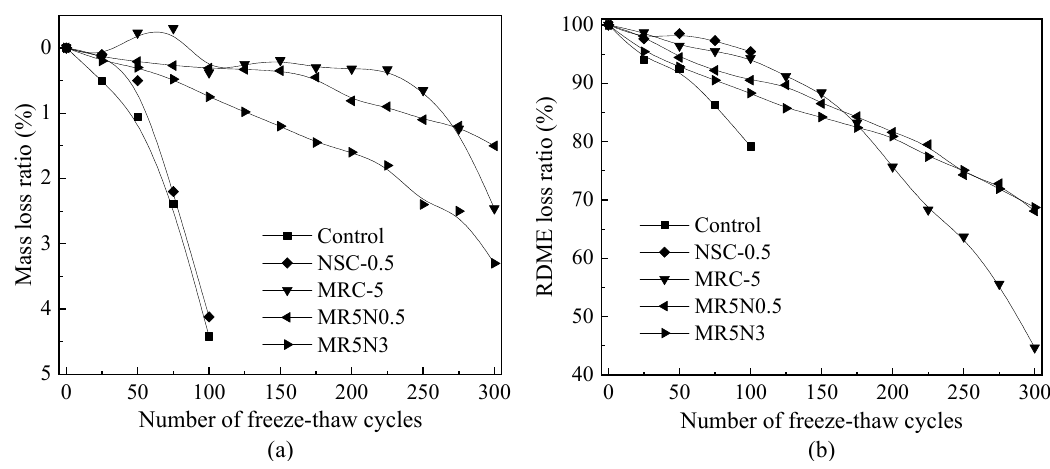
Figure 3. Loss ratios of concrete with rubber and nano-SiO 2 ( a ) mass, ( b ) RDME.